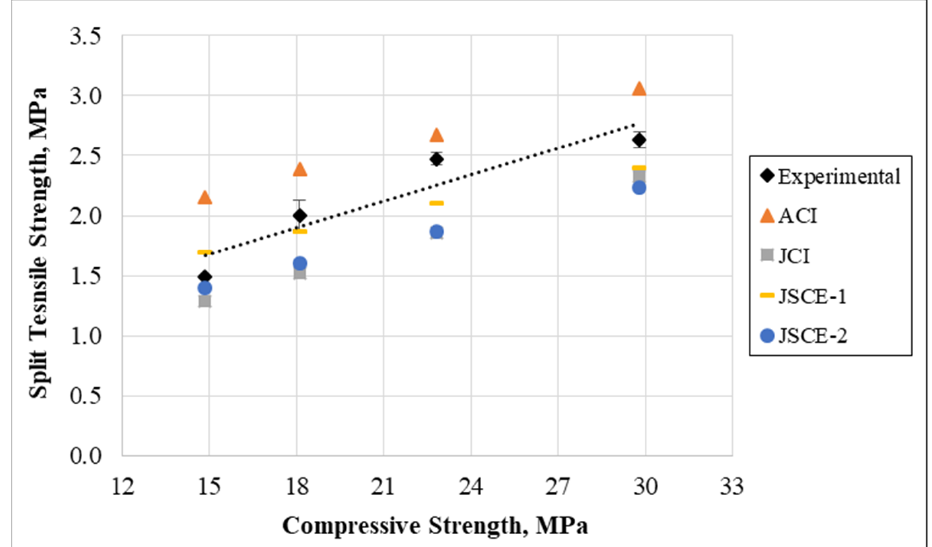
Figure 27. Relationship between compressive and tensile split strengths.